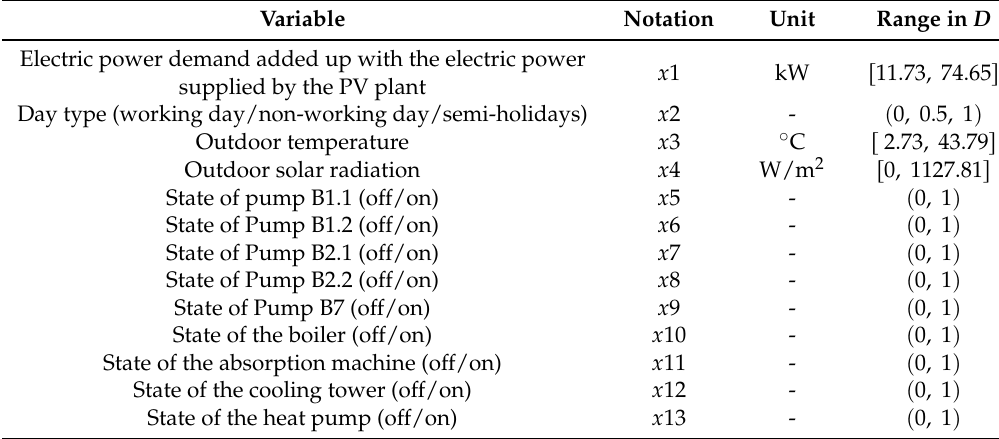
Table 5. List of variables used.